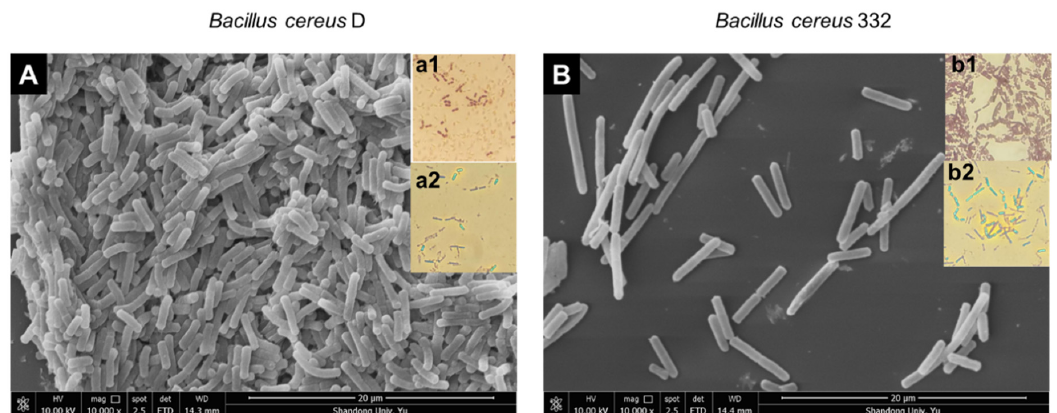
Figure 1. Micrographs showing the morphology of the B. cereus D ( A ) and B. cereus 332 ( B ) strains observed by scanning electron microscopy, Gram-staining (a1) and spore-staining (a2) of B. cereus D, and Gram staining (b1) and spore staining (b2) of B. cereus 332. Table 1. The biochemical and physiological characteristics of B. cereus D and B. cereus 332.